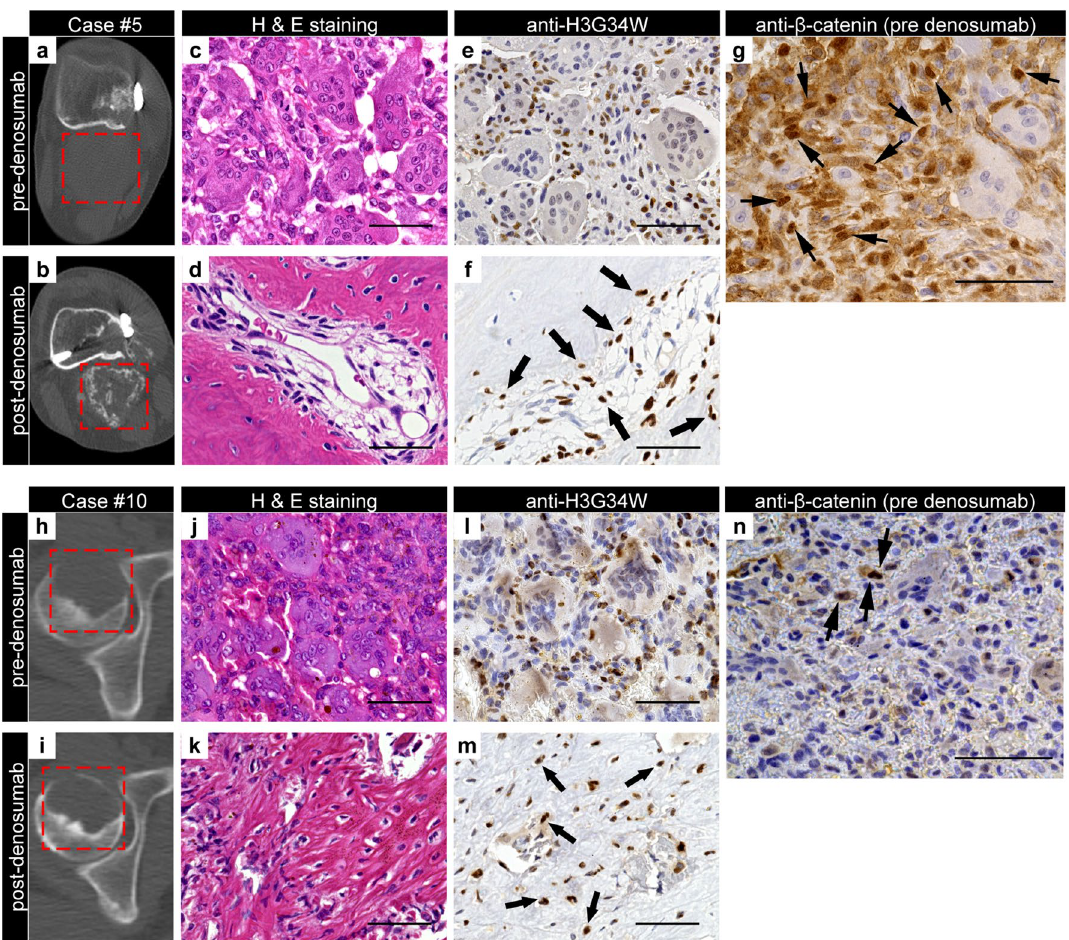
Figure 6. Nuclear positivity of β-catenin in GCTB-SCs predicts intra-tumoral bone formation of GCTB after denosumab treatment. ( a , b ) Axial computed tomography (CT) images (case #5) with no ossification before denosumab treatment ( a ) and massive bone formation after denosumab treatment ( b ). The red dashed line represents a tumor area located dorsal to the femoral bone. ( c , d ) Osteoclastic giant cells disappeared after denosumab treatment, and significant bone formation with residual focal tumor lesions was observed. ( e , f ) Mononuclear stromal cells were diffusely positive for the H3G34W mutation, whereas osteoclastic giant cells were negative. Transformed cells after denosumab treatment were positively stained for the H3G34W mutation (arrow). ( g ) A denosumab-naïve tumor specimen exhibited strong nuclear positivity for β-catenin (arrowhead) in GCTB-SCs, whereas giant cells were negative. ( h , i ) Another axial CT image (case #10) with an osteolytic lesion in the right femoral head ( h ). Bone formation was scarce despite several administrations of denosumab ( i ). The red dashed line represents tumor lesions. ( j , k ) Osteoclastic giant cells disappeared after denosumab treatment ( j ); however, the specimen consisted mainly of fine reticular fibrosis ( k ). ( l , m ) Mononuclear cells before denosumab treatment ( l ) and transformed cells inside fibrosis after that ( m ) were positive for H3G34W. ( n ) Stromal tumor cells were weakly positive for nuclear β-catenin in a poorly ossifying case (arrowhead): scale bars, 50